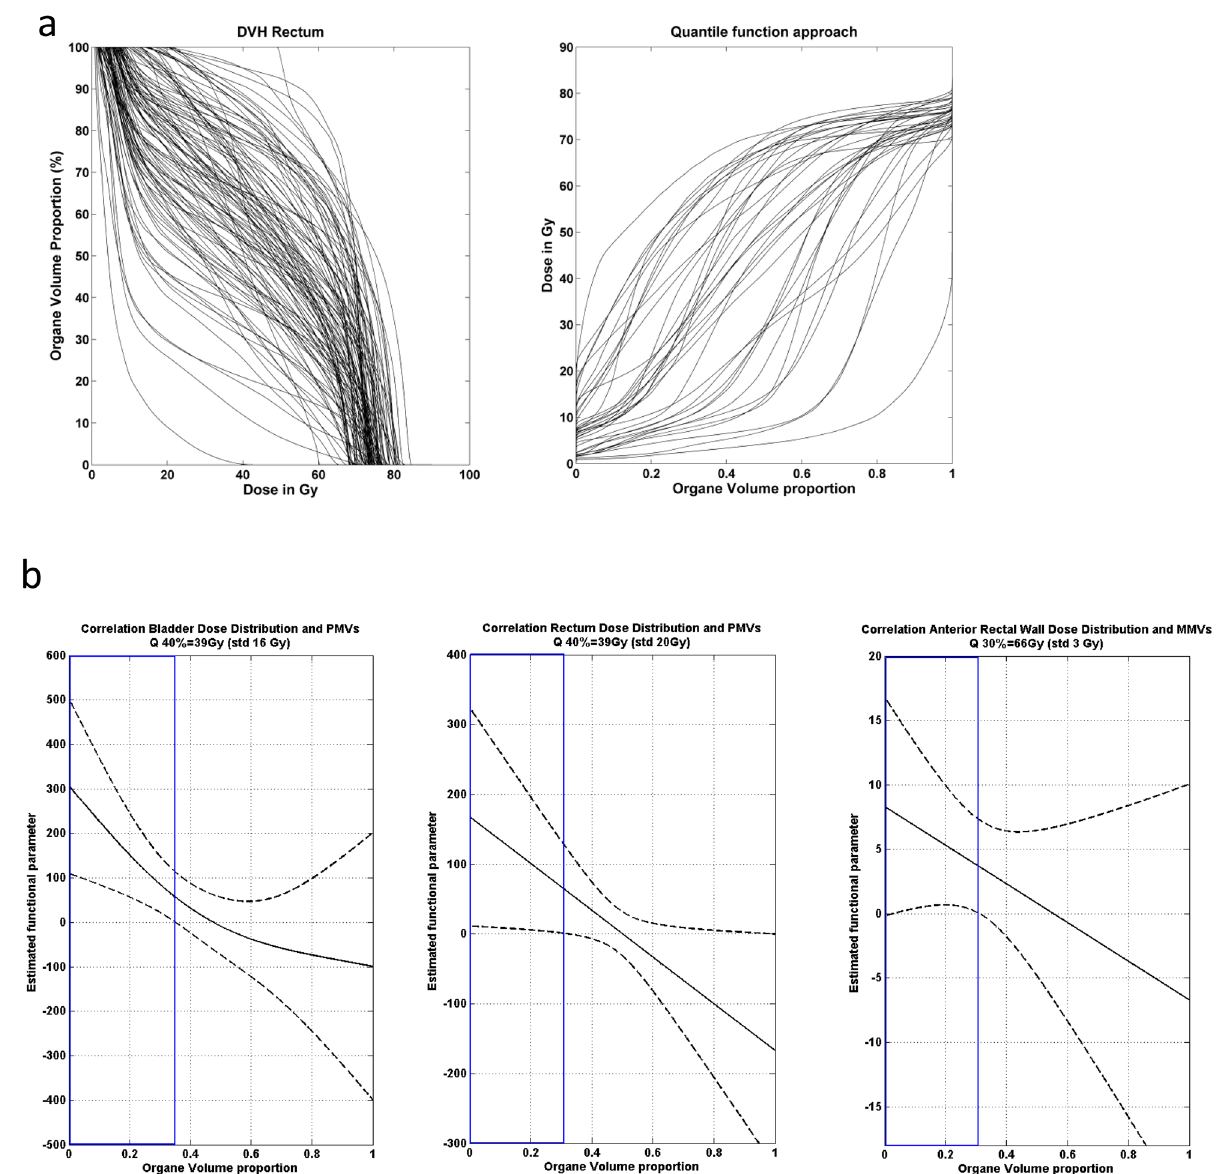
Figure 5. Correlations between DVHs and MVs. ( a ) Examples of patient-to-patient variability of rectum exposure through dose distribution histograms (DVH, left panel) and quantile functions (right panel). ( b ) Estimated functional parameters of the scalar on function regression representing the association of organ exposure with MV enumeration. Dashed lines represent the corresponding 95% confidence bands. The blue panels indicate a significant association between quantile doses and the number of